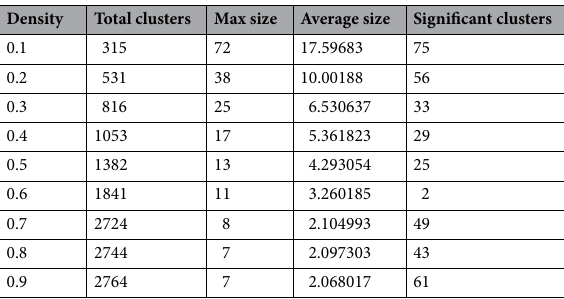
Table 1. Results of each DPclusO clustering.